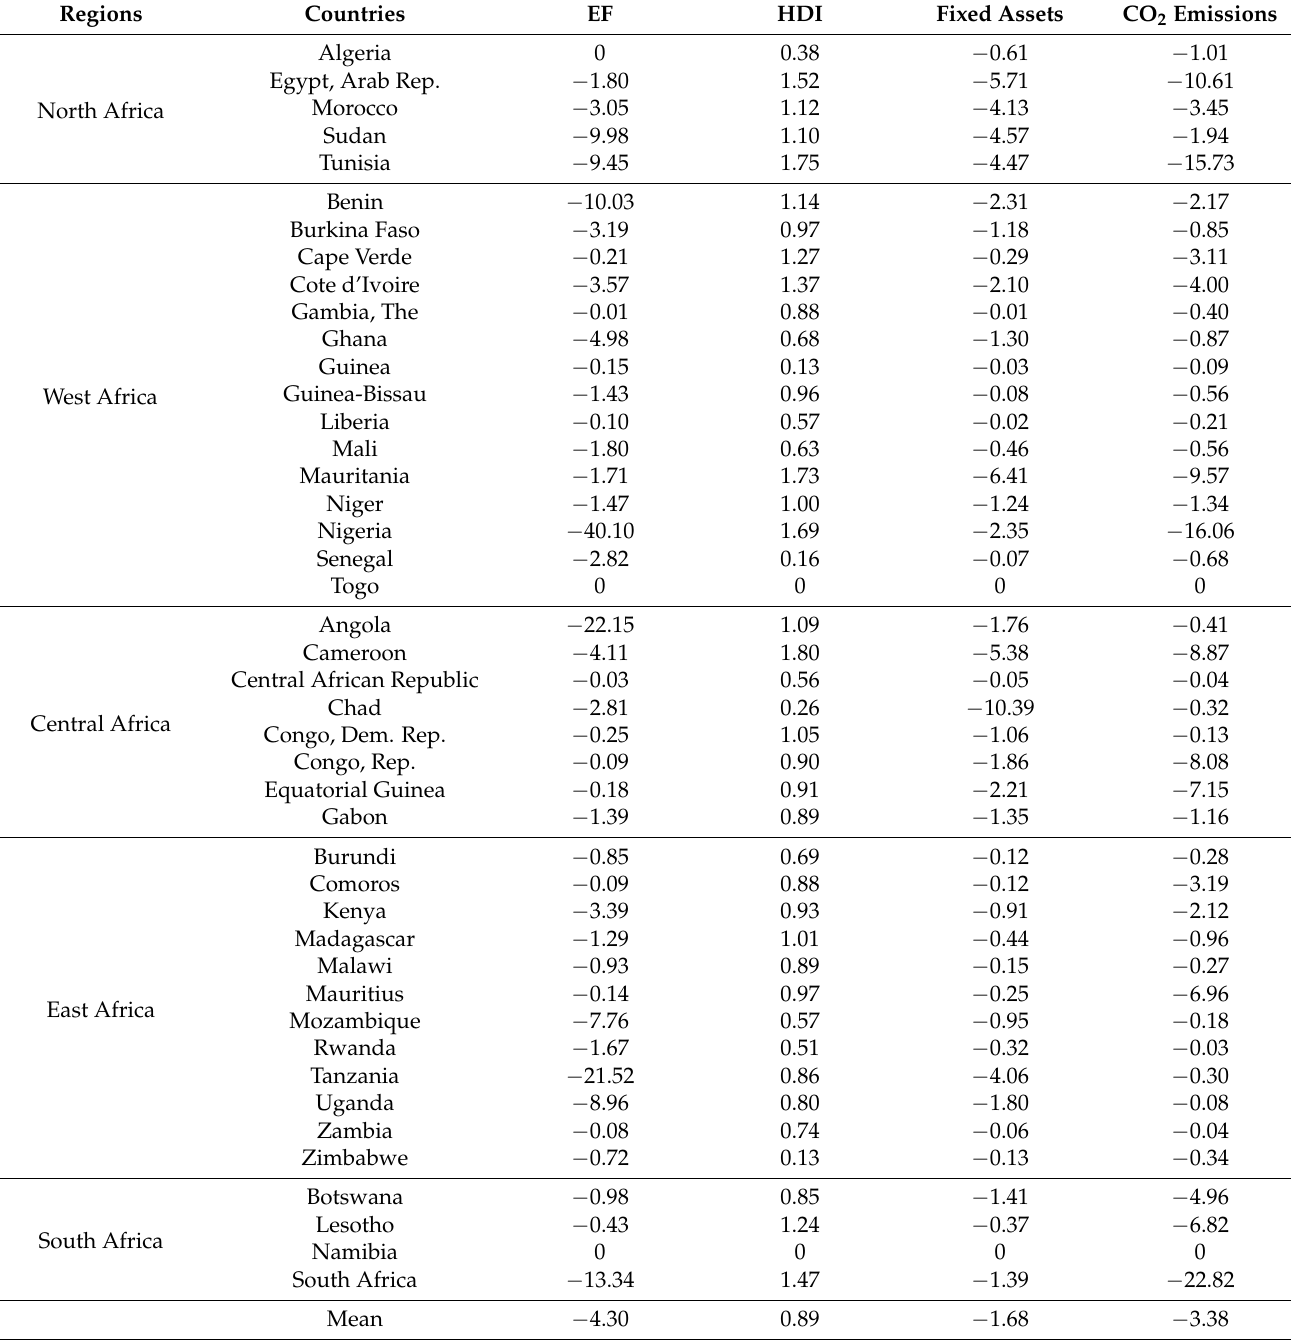
Table 8. Mean adjustment range for selected indicators in